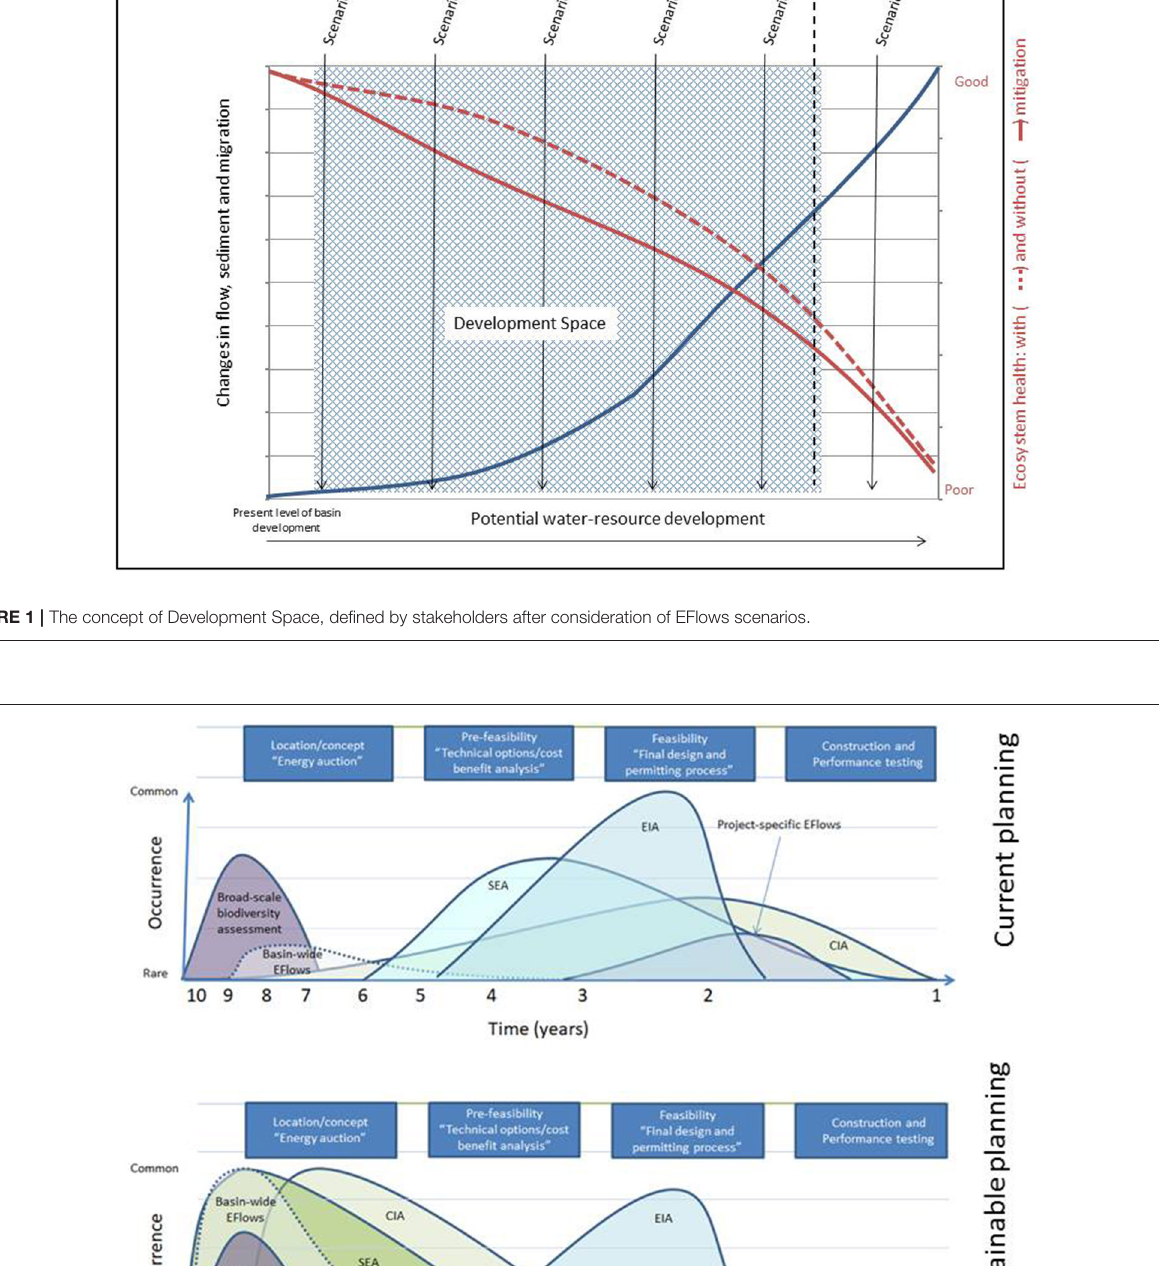
Frontiers in Environmental Science | www.frontiersin.org